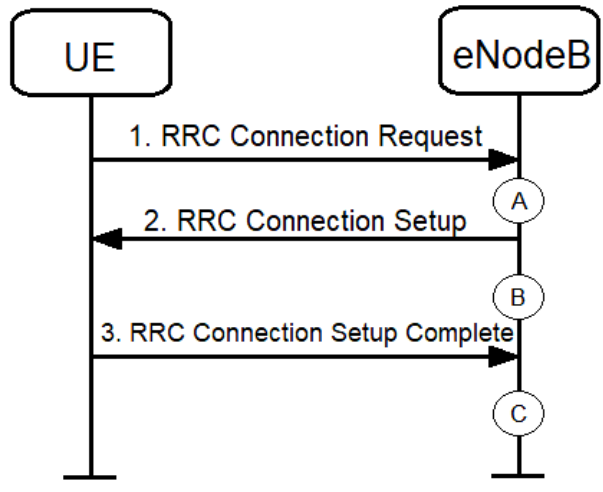
Figure 4. RRC connection setup procedure (adapted from [41]).